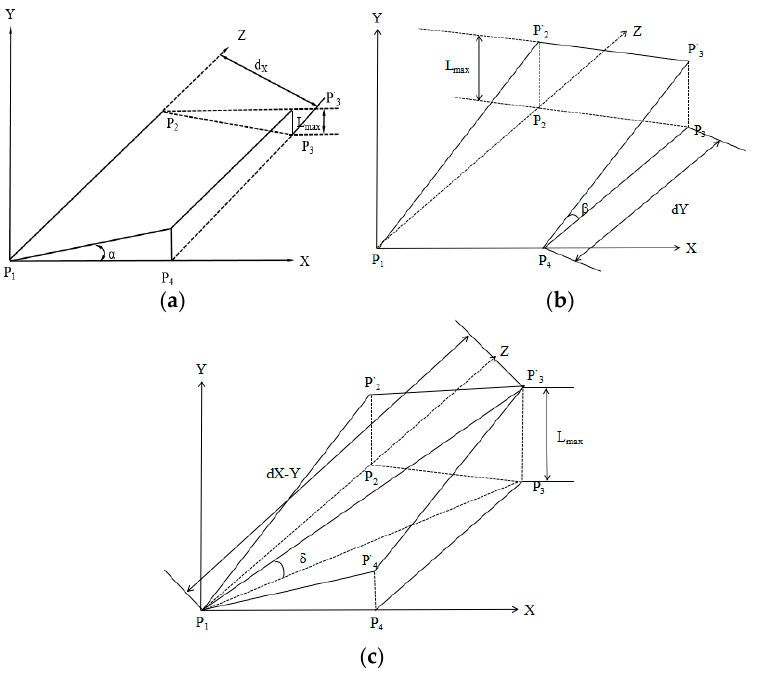
Figure 4. Schematic diagrams of the inclination levelling range. ( a ) Schematic diagram of the X -axis. ( b ) Schematic diagram of the Y -axis. ( c ) Schematic diagram along the diagonal line.